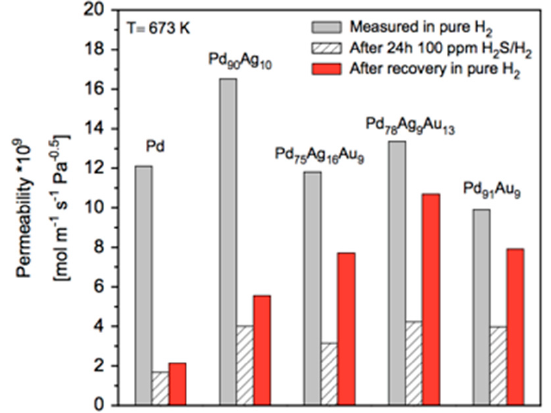
Figure 8. Hydrogen permeability at 400 °C (673 K) measured in pure hydrogen (grey bars), after exposure for 24 h to 100 ppm of H 2 S (cross lined bars) and after removing H 2 S and flux recovery (red bars). Reprinted from [124] with permission from Elsevier.